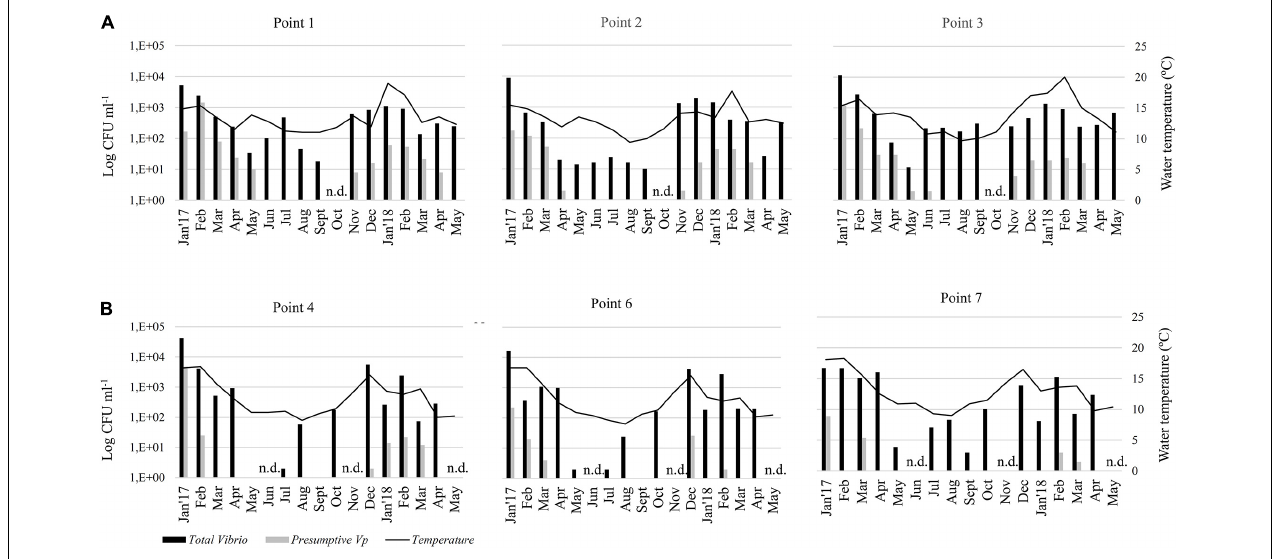
FIGURE 2 | Monthly abundance of total vibrios and presumptive V. parahaemolyticus in the pools of mussels’ samples in CHROMagar medium. Histograms show apparent concentrations (UFC ml − 1 ) based on CHROMagar plates that represents the arithmetic mean of 5 pools of each point. Samples were collected in two areas: (A) Valdivia River Estuary (Points 1, 2, and 3), and (B) Reloncaví Fjord (Points 4, 6, and 7). Seawater temperature ( ◦ C) is represented by a black line. n.d., not determined.